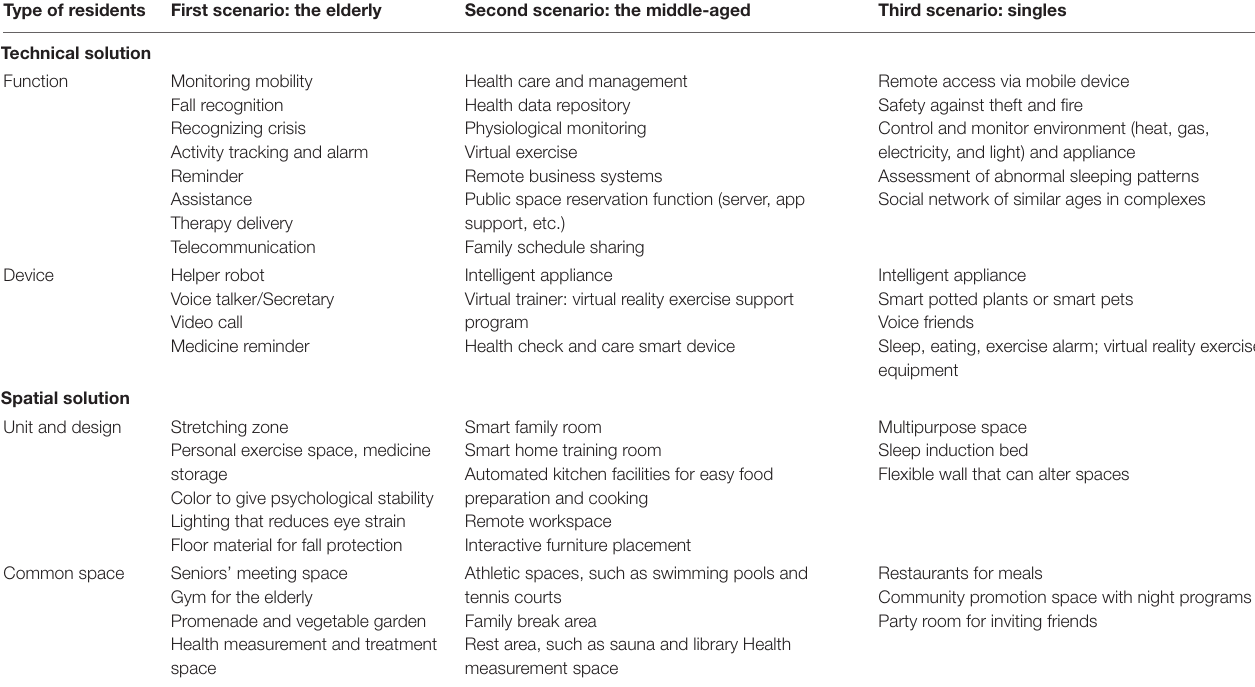
TABLE 3 | Technical and spatial